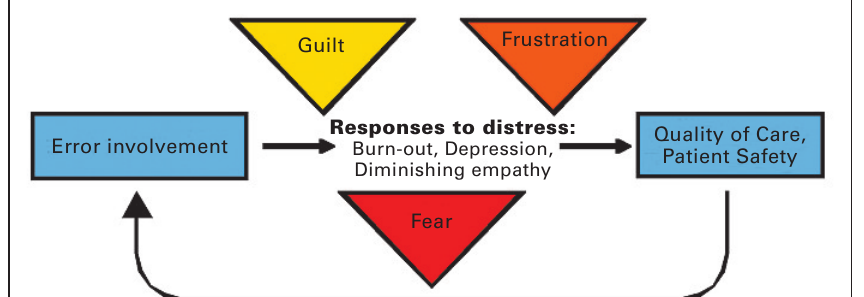
Reciprocal cycle of error involvement, emotional distress, and future errors.